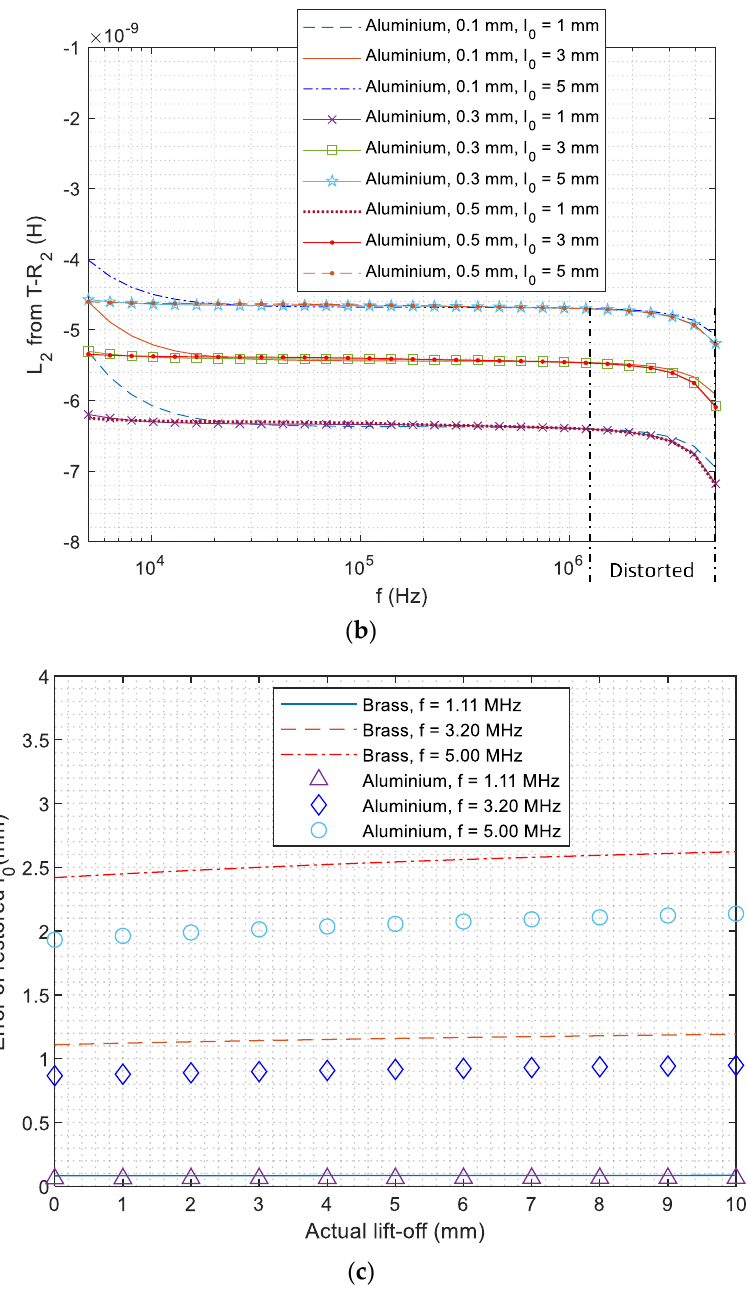
Figure 7. Distorted swept-frequency inductance (for high working frequencies up to 5 MHz) of different lift-off distances for T − R 2 above the conductive coating (on DP 1000 steel) with different thicknesses: ( a ) brass, ( b ) aluminium, and ( c ) error of the retrieved lift-off distance for coatings with thickness of 0.3 mm.